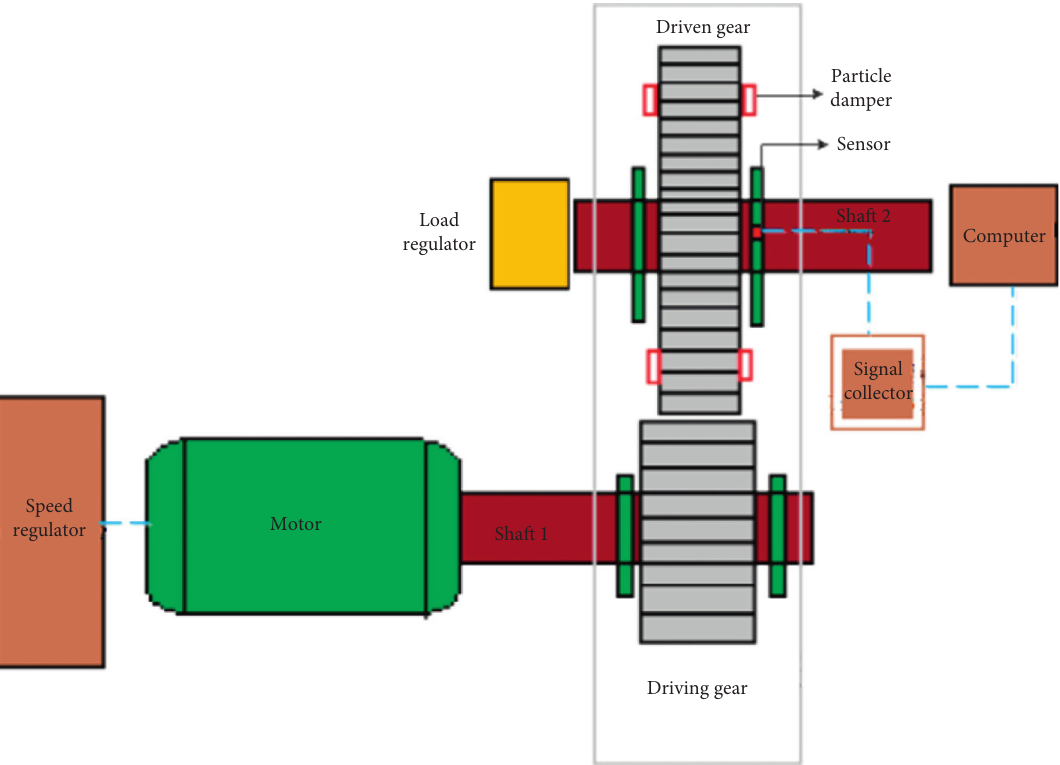
Figure 15: Schematic of the test system.